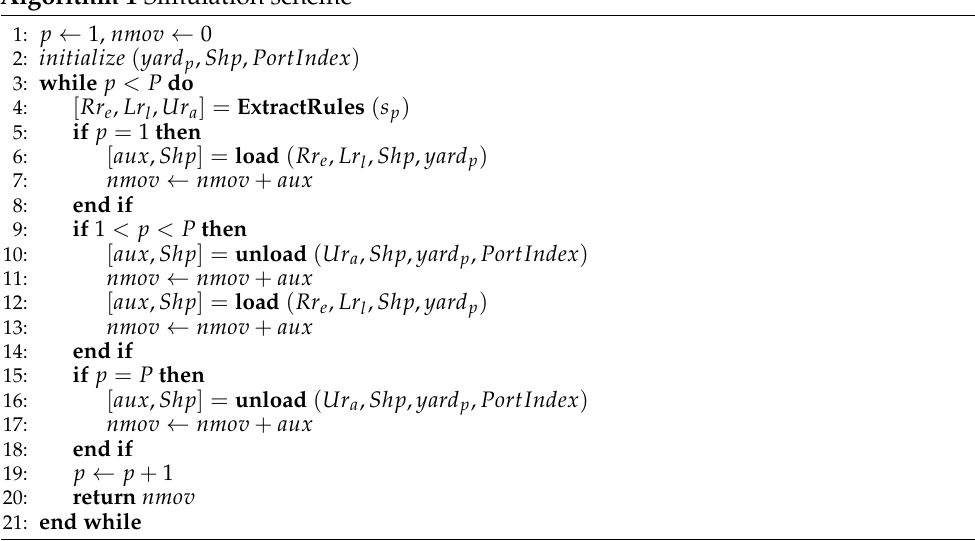
Algorithm 1 Simulation